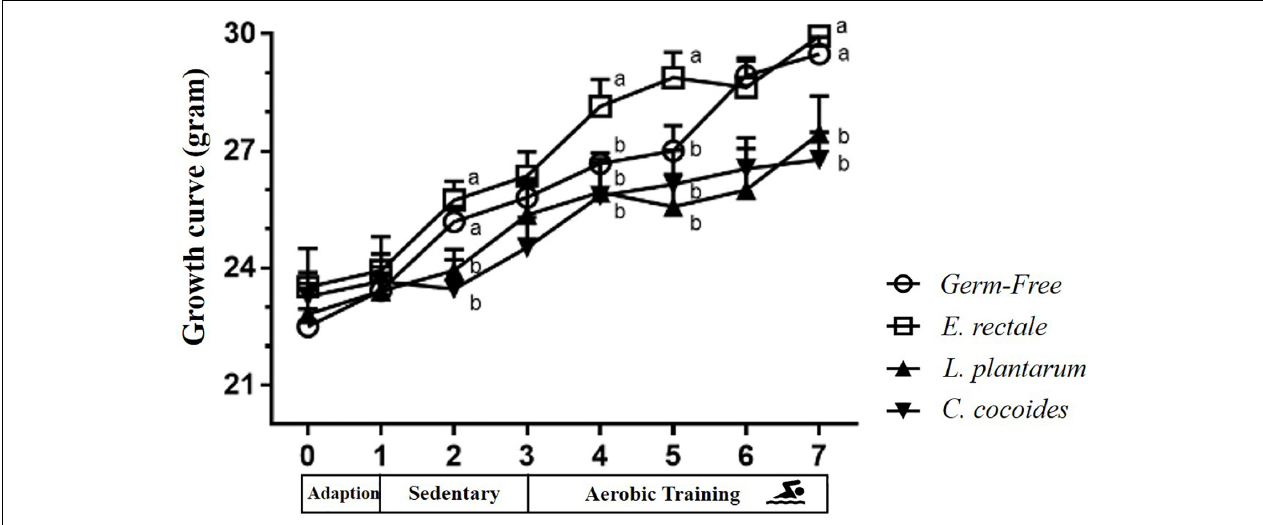
FIGURE 8 | Effect of indicated gnotobiotic groups on growth curve profiles. Data are mean ± SEM ( n = 6–8/group) and the symbols with different superscript letters (a, b, and c) are significantly different at P < 0.05 at the same time.